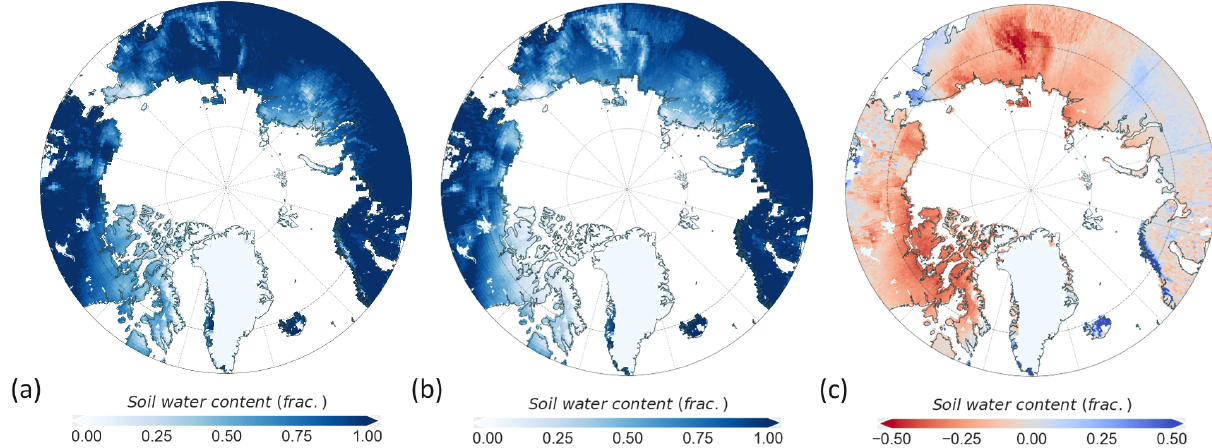
Figure 8. Mean fractional water content of the upper soil column in May, June, and July, using the Static (a) and Dynamic (b) schemes and their difference (c) . Differences are calculated by subtracting the Static from Dynamic simulation